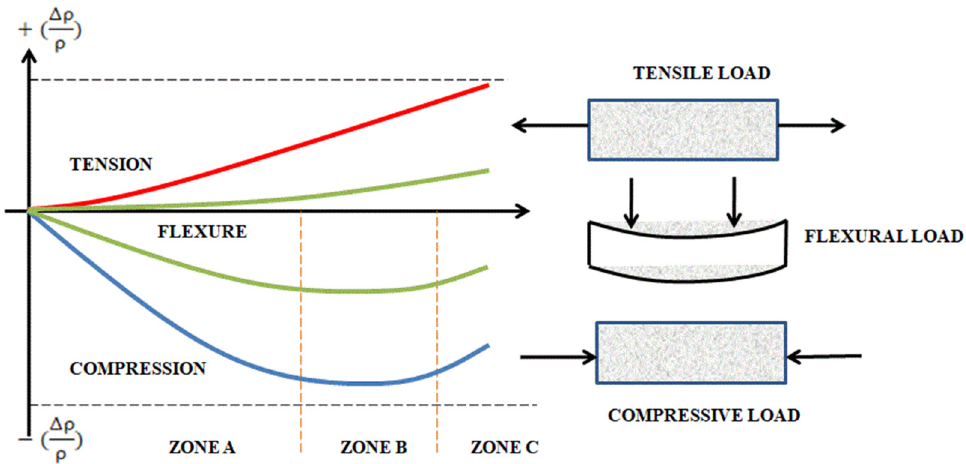
Figure 9. Graphical representation of fractional changes in resistivity for different loading